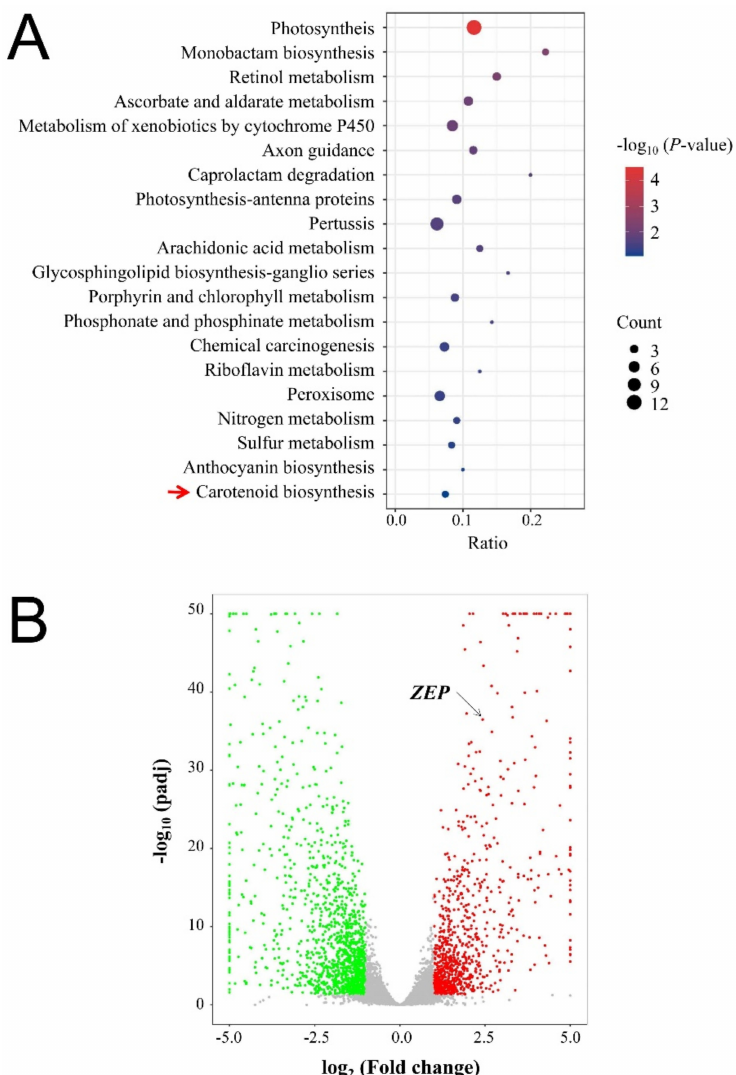
Figure 3. Metabolic pathway analysis of differentially expressed genes identified in the transcriptome. ( A ) Bubble diagram analysis of differentially gene expressions in metabolic pathway. ( B ) Volcano map of differentially expressed genes. Data are normalized and transformed of gene expression in zebra-green striped leaves and zebra-yellow striped leaves ( n = 3). The red arrow points to the Carotenoid biosynthesis, and the black arrow points to the ZEP